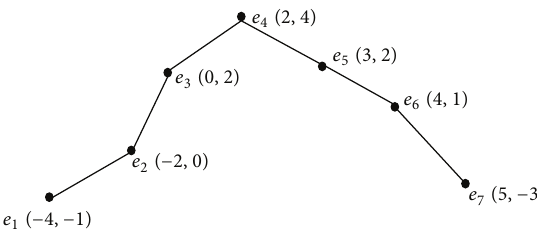
Figure 9: A formation of entities at a time-point 𝑡